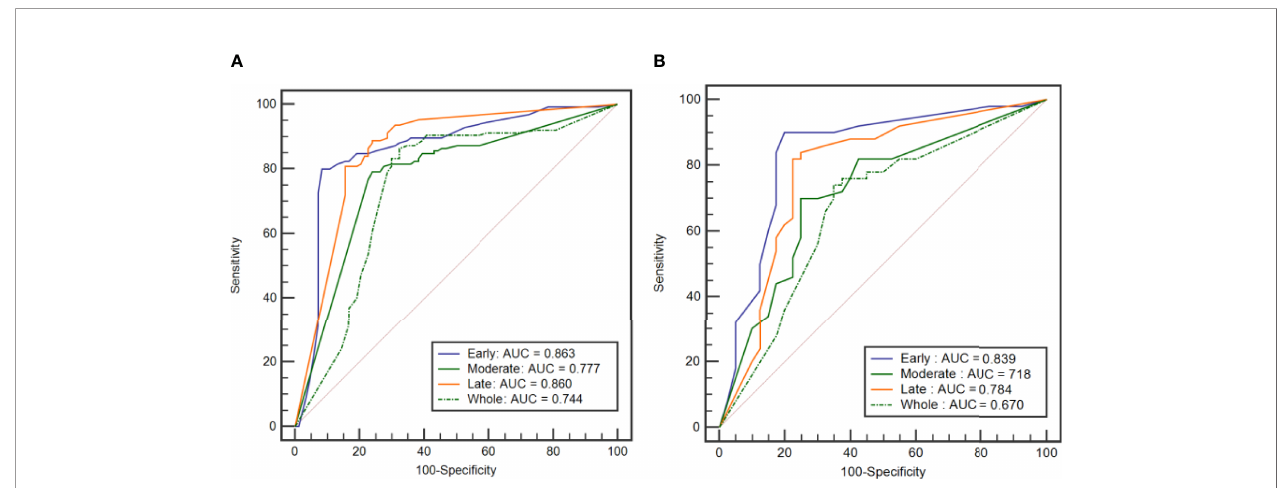
FIGURE 3 | ROC curves of the DT classi fi cation models established by using the features extracted from the three intratumoral subregions and the whole tumor area. (A) ROC curves from the training cohort. (B) ROC curve from the external validation cohort.